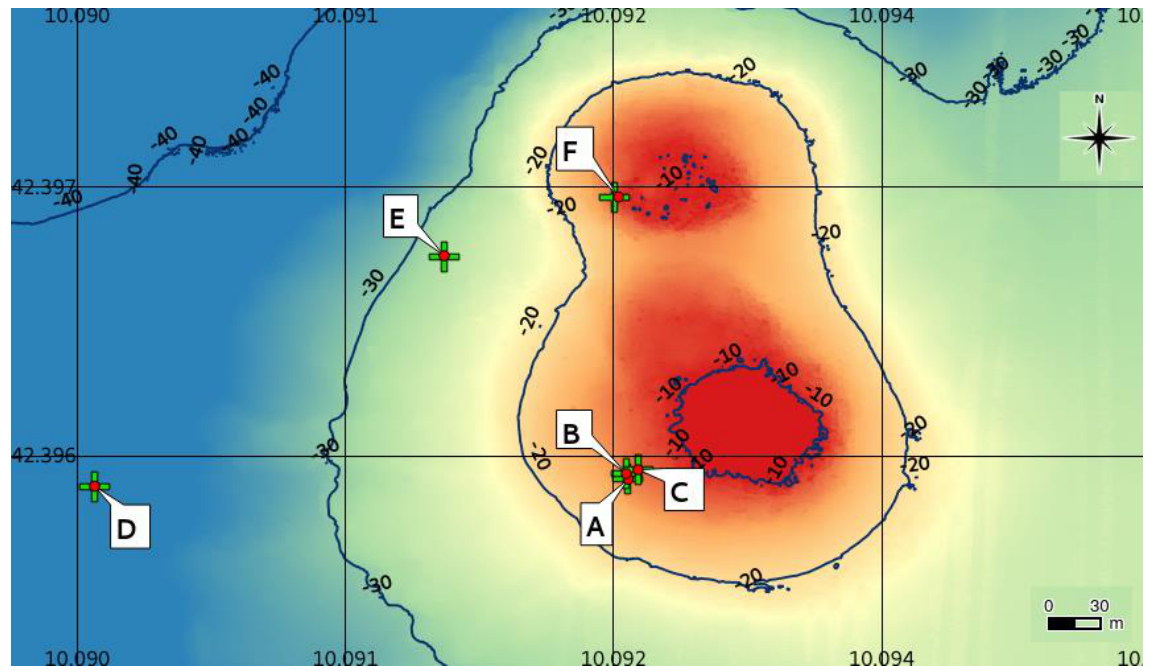
Figure 11. Bathymetric map of the area inspected during the 2019 campaign (Courtesy of Italian Hydrographic Institute). The green crosses and the letters highlight a selection of interesting point obtained from the analysis of the video images.